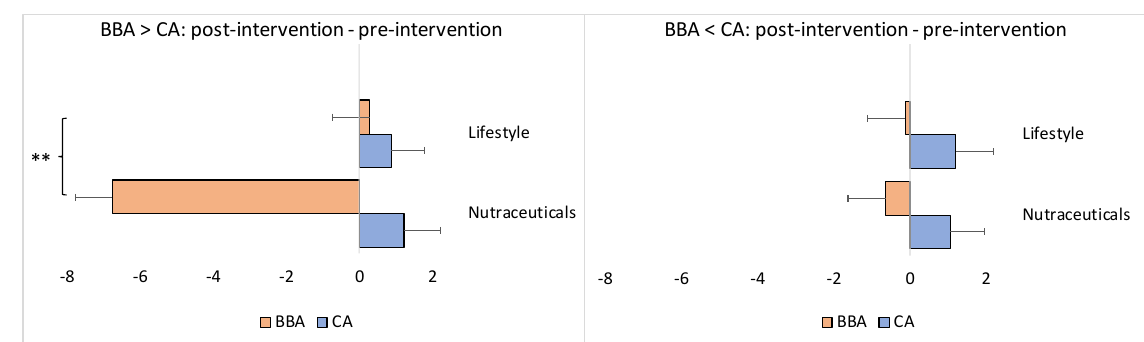
Figure 5. Difference between the post- and pre-intervention endpoints as a function of the intervention (i.e., nutraceutical supplementation versus lifestyle changes) separately for situations when the pre- intervention BBA was older or younger than the CA. The x -axis represents the difference in years. CA: chronological age; BBA: biological brain age. The asterisks denote p < 0.01 (**). The bars represent the